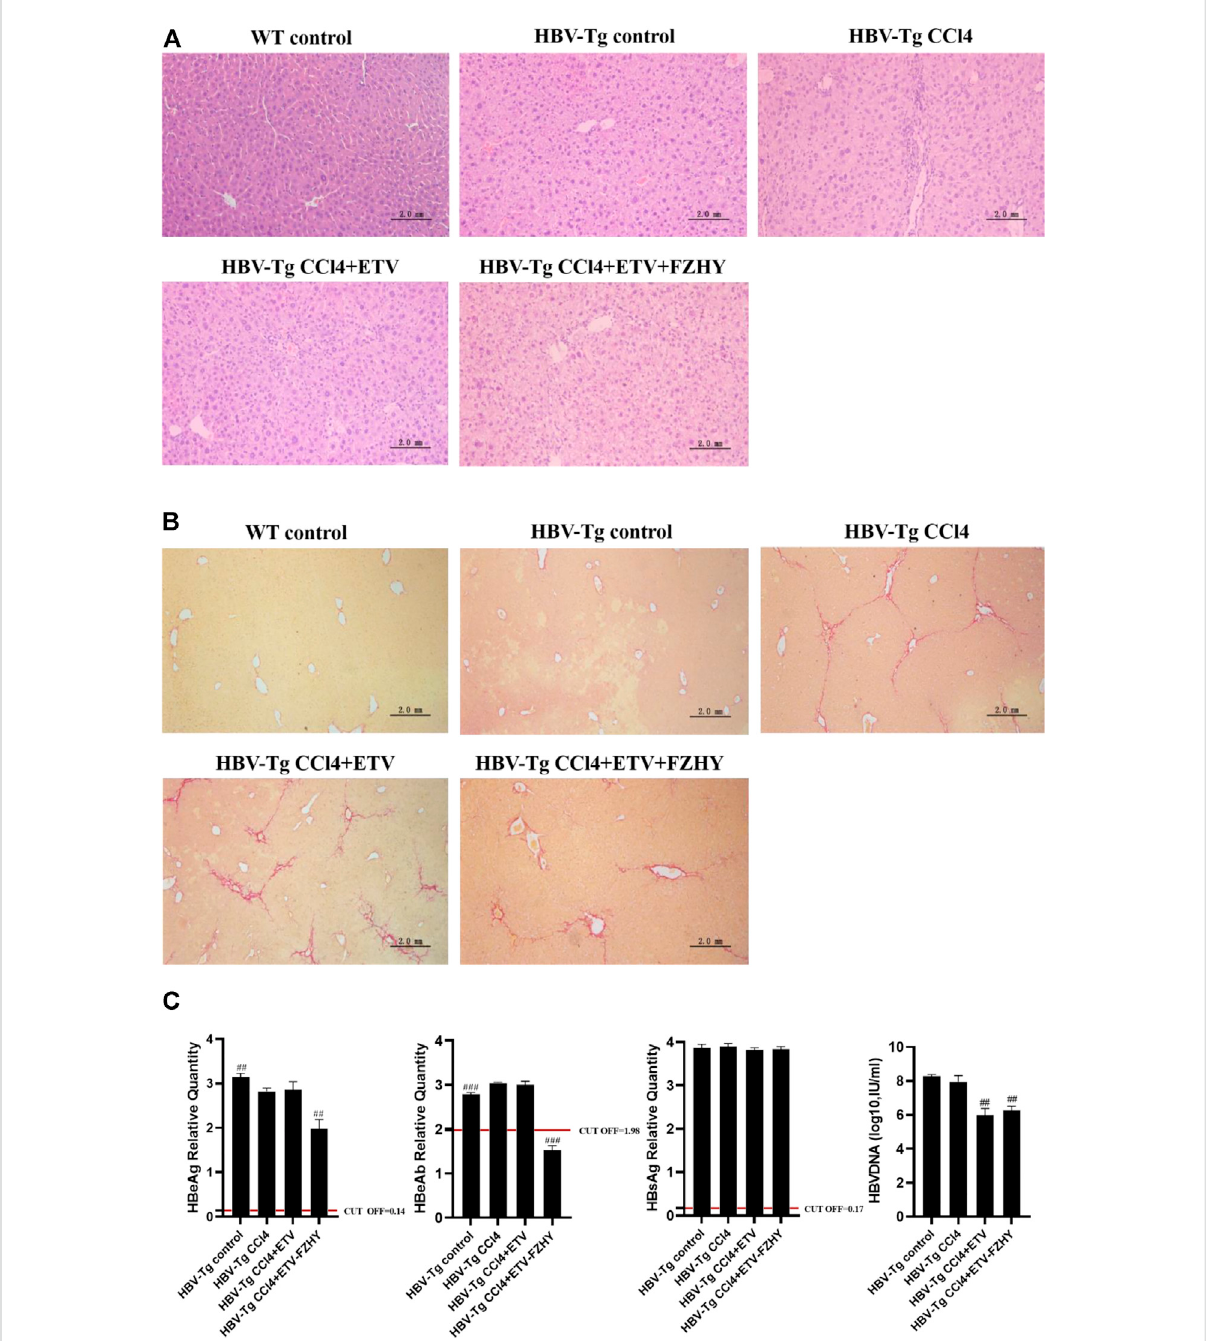
FIGURE 2 The pharmacological effect of FZHY on the expression of HBeAg, HBeAb, HBsAg, and HBV-DNA in CCl4-induced liver fi brosis HBV-Tg mice. (A) . HE staining. (B) . Sirius red staining. (C) . HBeAg, HBeAb, HBsAg, and HBV-DNA detection in HBV-Tg mice serum. Each group vs.